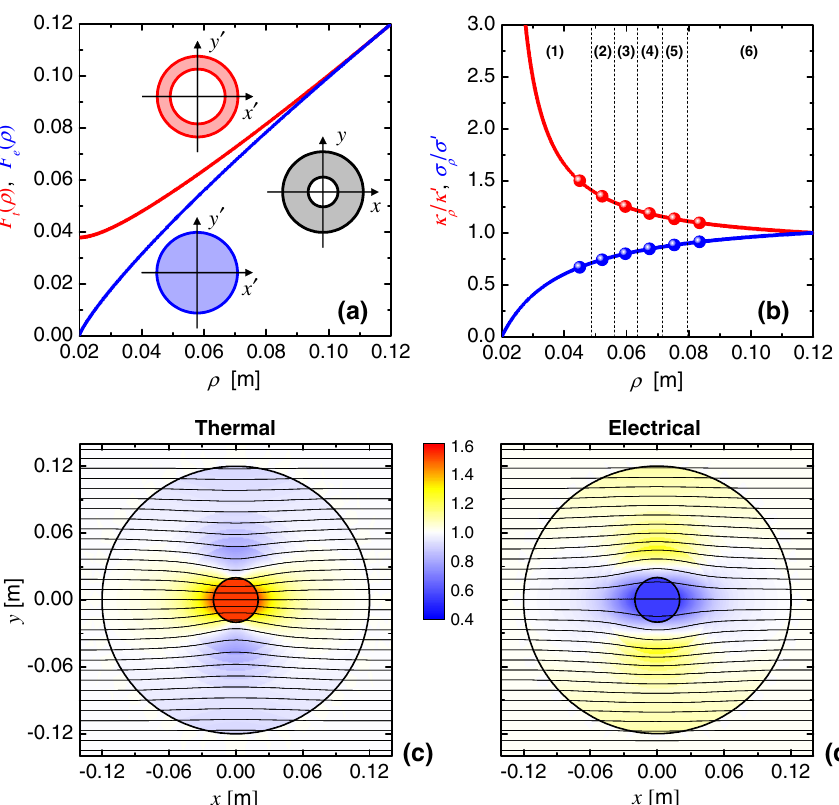
FIG. 3. (a) Radial coordinate transformations implementing the ideal thermal concentrator (red) and electrical cloak (blue), within an annulus of radii R 1 ¼ 2 cm and R 2 ¼ 12 cm. Also shown is a qualitative illustration of the mapping between auxiliary and transformed spaces. (b) Corresponding relevant constitutive-tensor components κ ρ = κ 0 ¼ κ 0 = κ ϕ (red) and σ ρ = σ 0 ¼ σ 0 = σ ϕ (blue). Outside the annulus R < ρ < R F ρ Þ ¼ ρ , and the parameters coincide with those in the auxiliary 1 2 , the coordinate transformations reduce to the identity, t;e ð space ( κ 0 and σ 0 ). The vertical dashed lines indicate the six-layer piecewise-constant radial discretization considered, with the markers representing the constant values assumed in each layer. (c),(d) Numerically computed steady-state total heat-flux and electrical current- density magnitudes, respectively, with the superimposed streamlines indicating the local